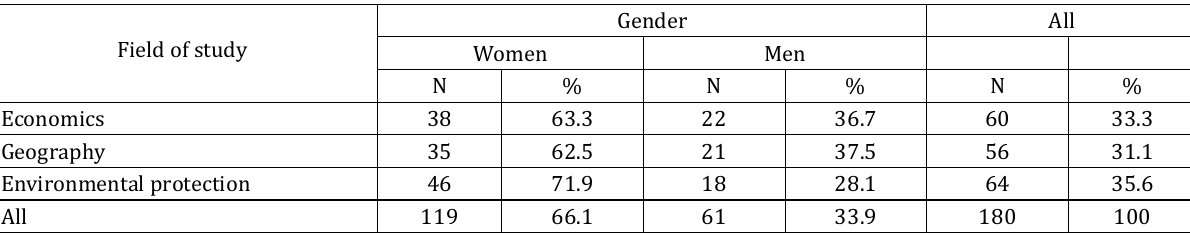
Table 1. Selected socio-economic characteristics of the respondents Field of